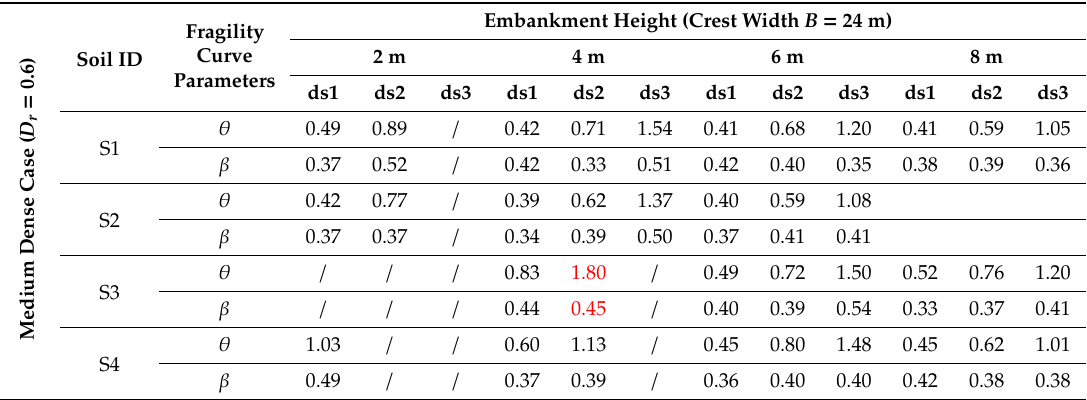
35 0 . = D r ( e a s C e oo s L